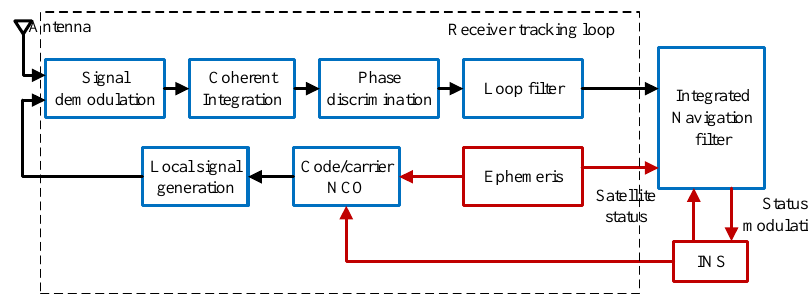
Figure 1. Structure diagram of the GNSS/INS deeply coupled system.